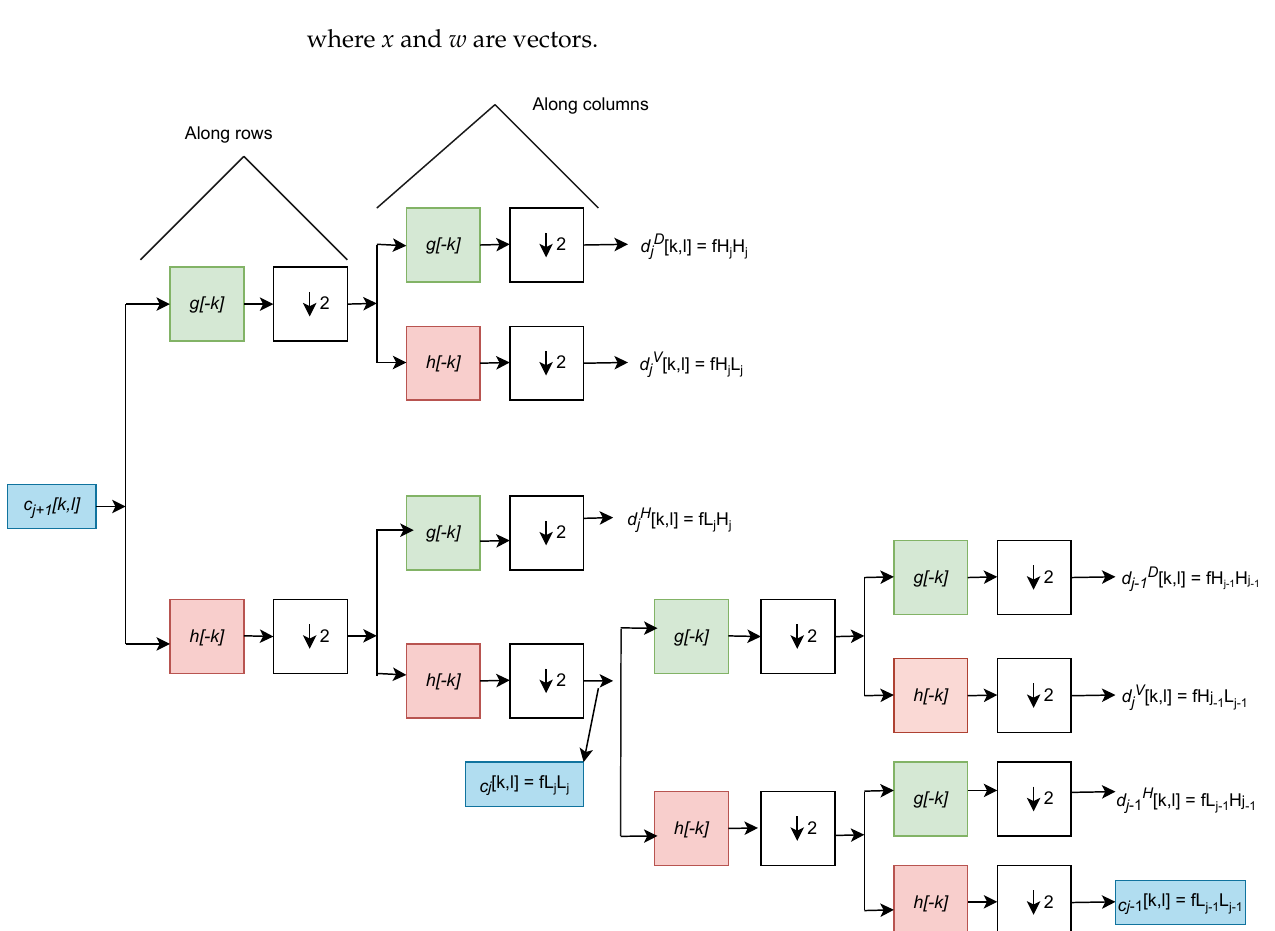
Figure 1. Two − stage 2D wavelet decomposition. The lower-frequency filter coefficient (approxi- mation coefficient) decomposes into lower and higher filter coefficients at each stage of the wavelet decomposition. The decomposition starts with rows downsampling by a factor of two, followed by the same operation along with the columns (the operation can be carried out vice versa, starting with a column and then a row), where c is the low-frequency coefficient (coarse coefficient), d is the high- frequency coefficient (detailed coefficient), g is the high-frequency filter, and h is the low-frequency filter. The ↓ 2 operator is the downsampling/subsampling operator with a factor of two. At every stage of wavelet decomposition, the low-frequency coefficient decomposed into high-frequency and low-frequency